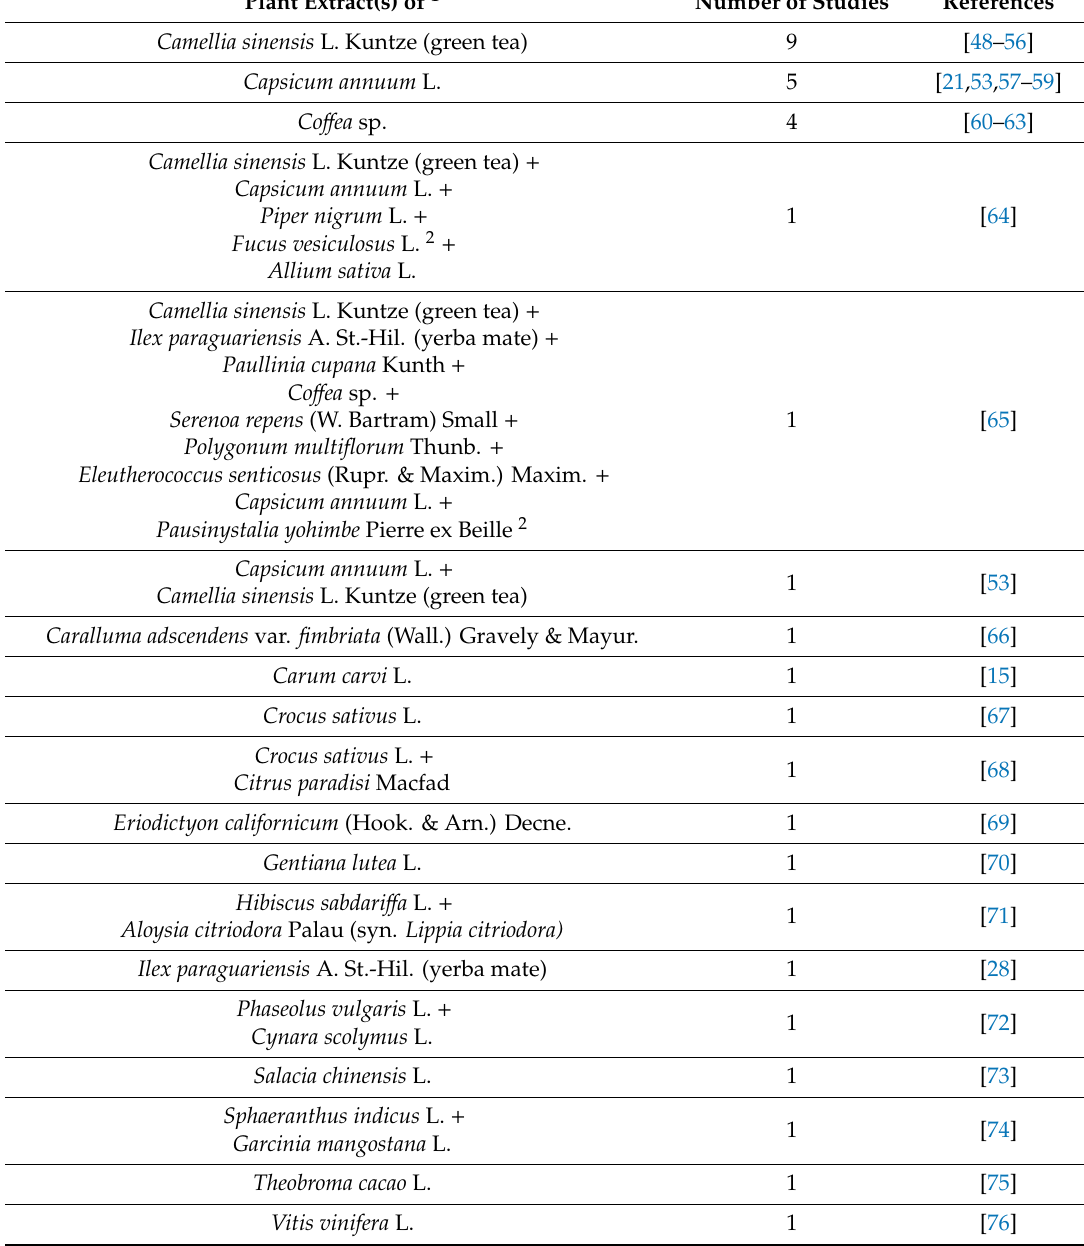
Table 1. Types of plant extracts tested in the